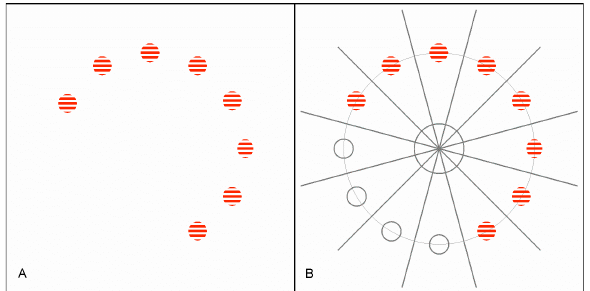
Figure 3. A. Example of a possible search display with eight items in similarity level 3. The target-item is located at three o’clock. B. Same situation as in A. For data analysis, the display is split up into twelve equally-sized sectors. The target-item at three o’clock (corresponding to 45°) was considered fixated if the coordinates of a fixation were between 30° and 60° and additionally outside the central region of 0.8° vis- ual angle in